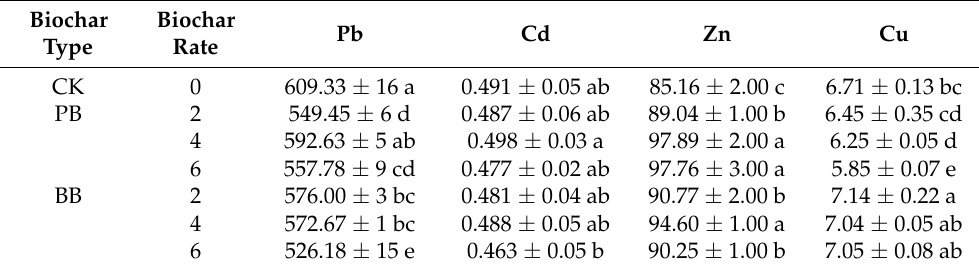
Table 5. Concentration of the soil heavy metal fraction bound to Fe/Mn oxides (mg kg − 1 ) determined with the BCR sequential extraction